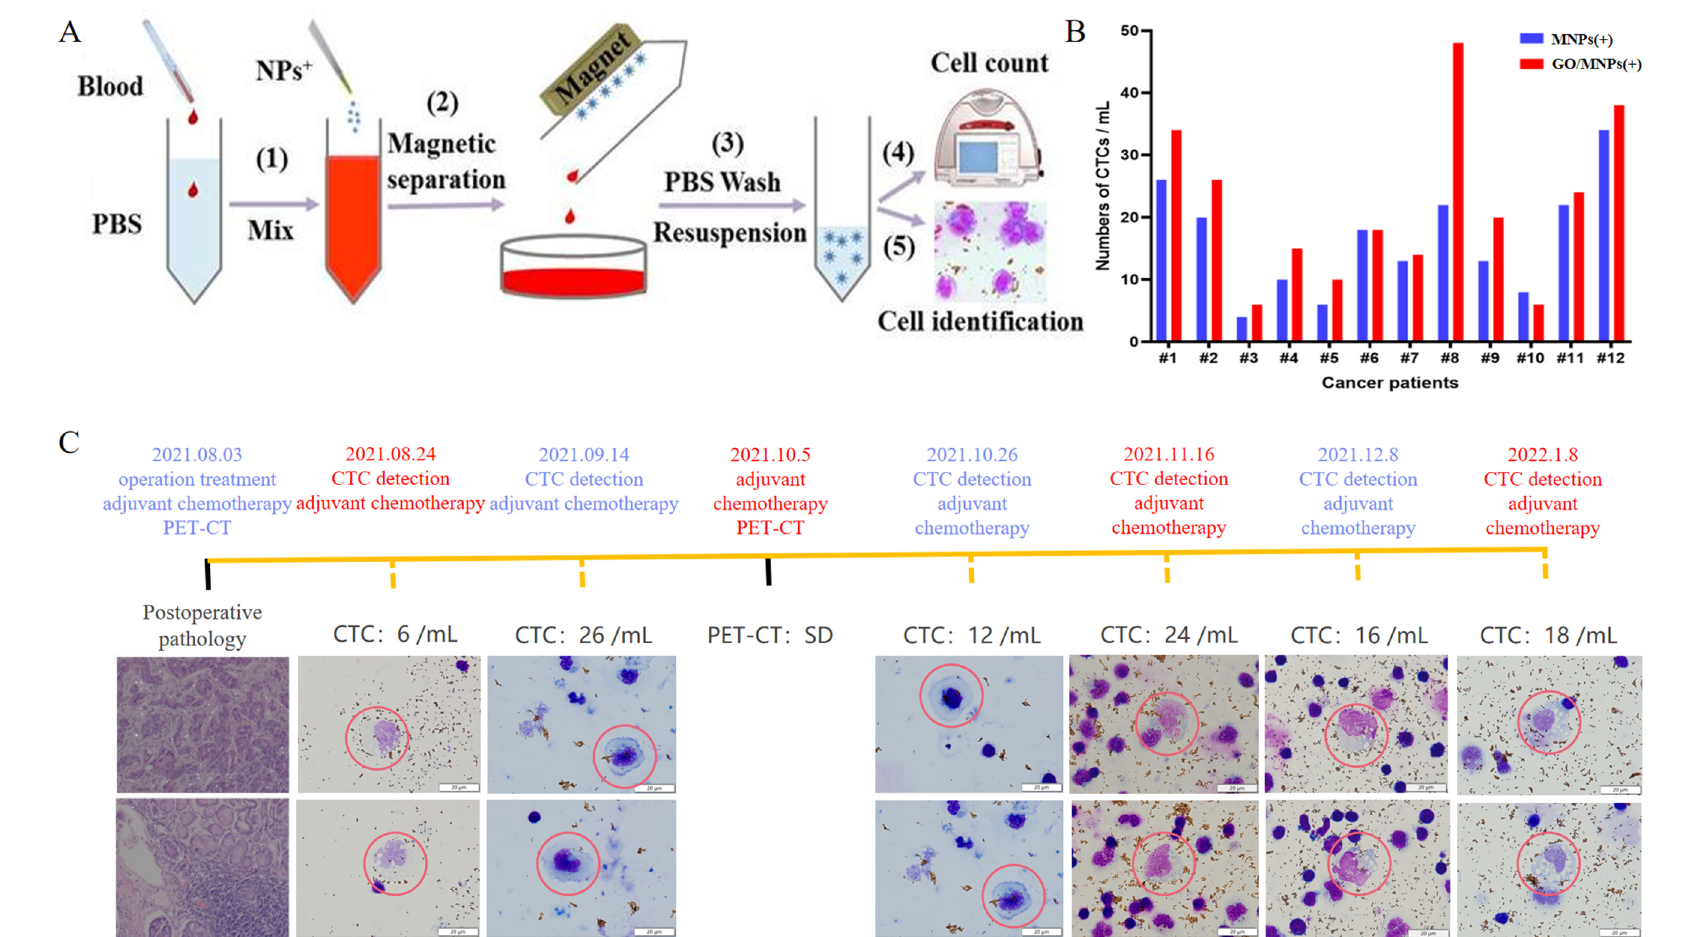
Figure 6. Validation of charged nanoprobes for the detection of circulating tumor cells in the clinical. ( A ) illustration conceptual of electrostatic nanoprobes for detecting CTCs; ( B ) CTC detection results of MNP(+) and GO/MNP(+) nanoprobes in clinical samples; ( C ) detection results from the same patient at different time points. Pathological morphological analysis of cells was performed under the microscope (bar = 20 um).